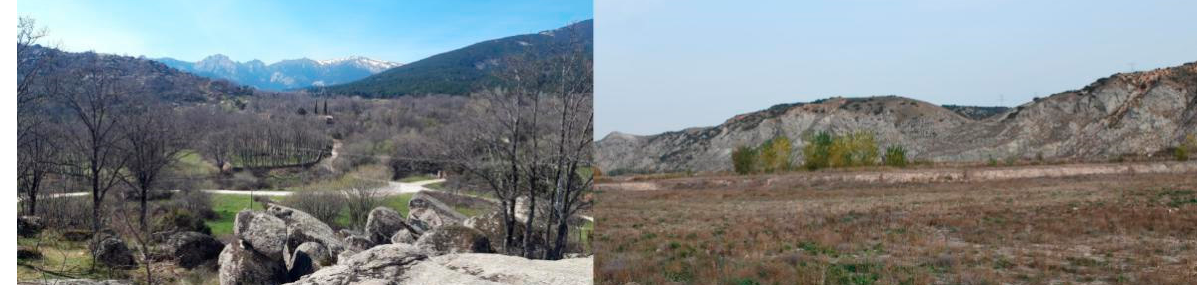
Figure 1. Typical scenes of the two landscapes.